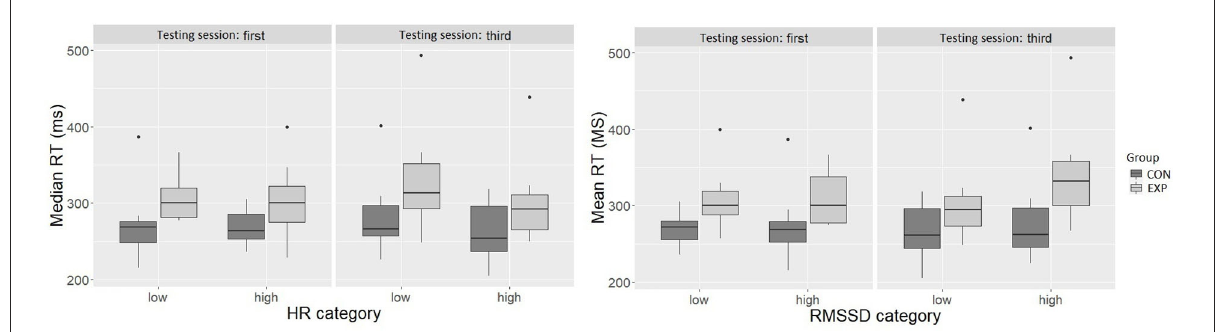
FIGURE6 The relationship of HR (x-axis; left-side graph) and RMSSD (x-axis; right-side graph) categorical variables with median RTs (ms) (y-axis; both graphs). The box depicts 50% of all values (IQR). The top 25% and bottom 25% of all values are excluded from the box. The top and bottom of the whiskers are the minimum and maximum, excluding outliers (outliers defined 1.5 x IQR). The horizontal line inside the box represents the median